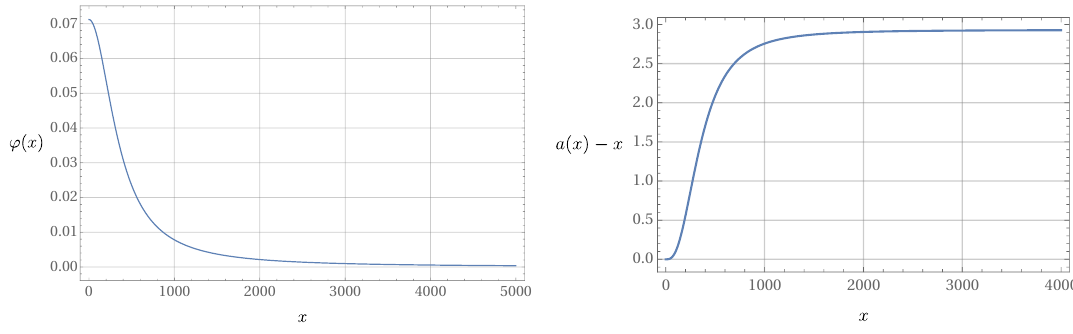
Figure 1 . Left panel : pro(cid:12)le of the bounce solution ’ ( x ) in the presence of gravity. It is obtained for the potential (2.25) with the parameters (cid:21) (cid:3) , (cid:11) , (cid:12) given in (2.19). The center of the bounce is at ’ (0) = 0 : 0712, its size is R = 350 : 2996 and the tunneling exponent is B = 2062 : 5836. Right panel : di(cid:11)erence between the curvature radius and its asymptotic value, a ( x ) (cid:0) x , for the same parameters as in the left